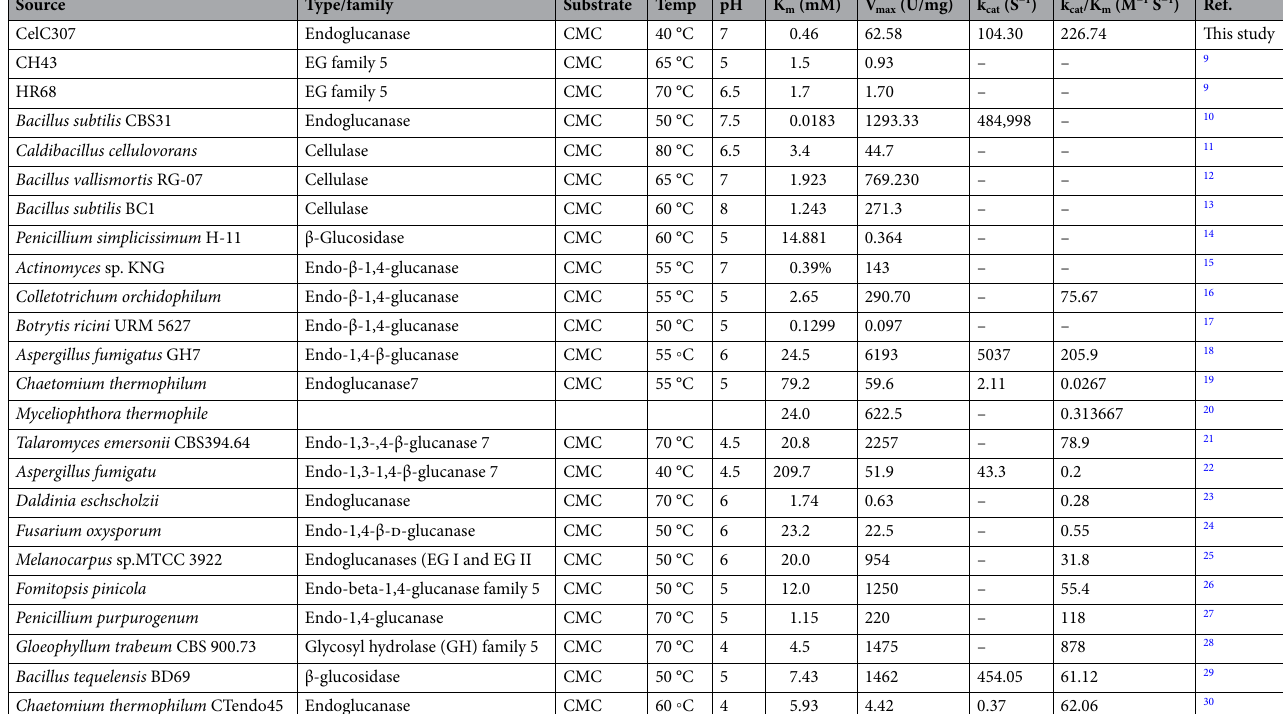
Table 3. Comparison of activity, temperature, pH and kinetic parameters of CelC307 with other studied members of glycoside hydrolase